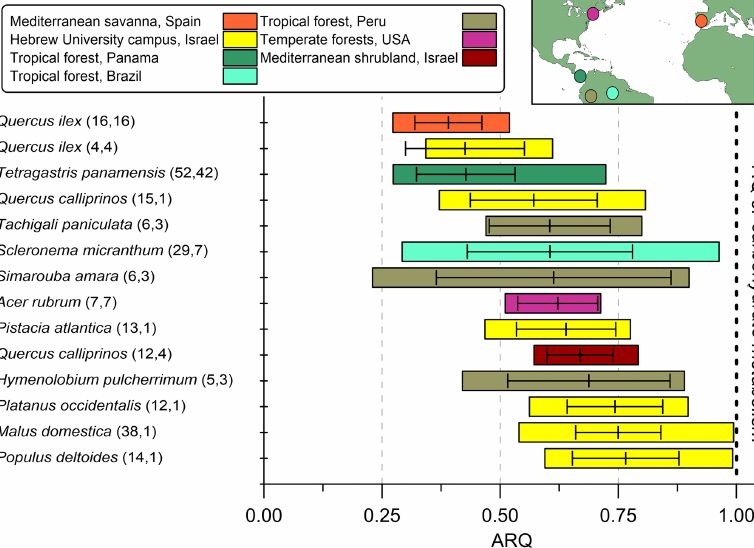
Figure 3. Summary of steady-state ARQ (ratio of CO 2 efflux / O 2 influx for tree stems) for 12 species ( n measurements, n individuals). Gases were sampled from chambers at breast height ( ∼ 1 . 3m above soil surface), except for the Q. calliprinos in the Mediterranean shrubland, in which chambers were placed near the stem base due to branching stems. Vertical lines are mean values, error bars represent one standard deviation, and colored bars represent the range of measured ARQ values. The Peru data are from Angert et al. (2012). The horizontal bars were ordered according to increasing mean